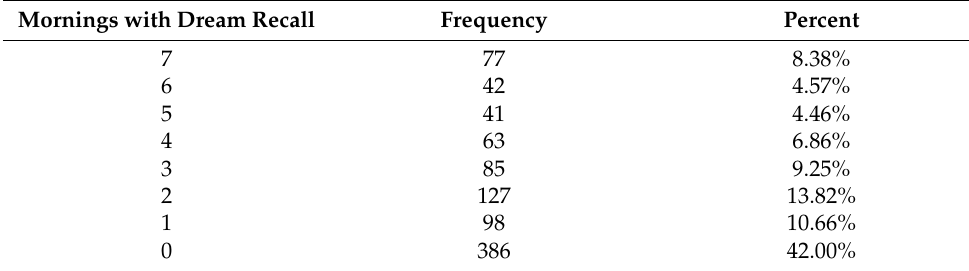
Table 2. Distribution of dream recall frequency ( n =